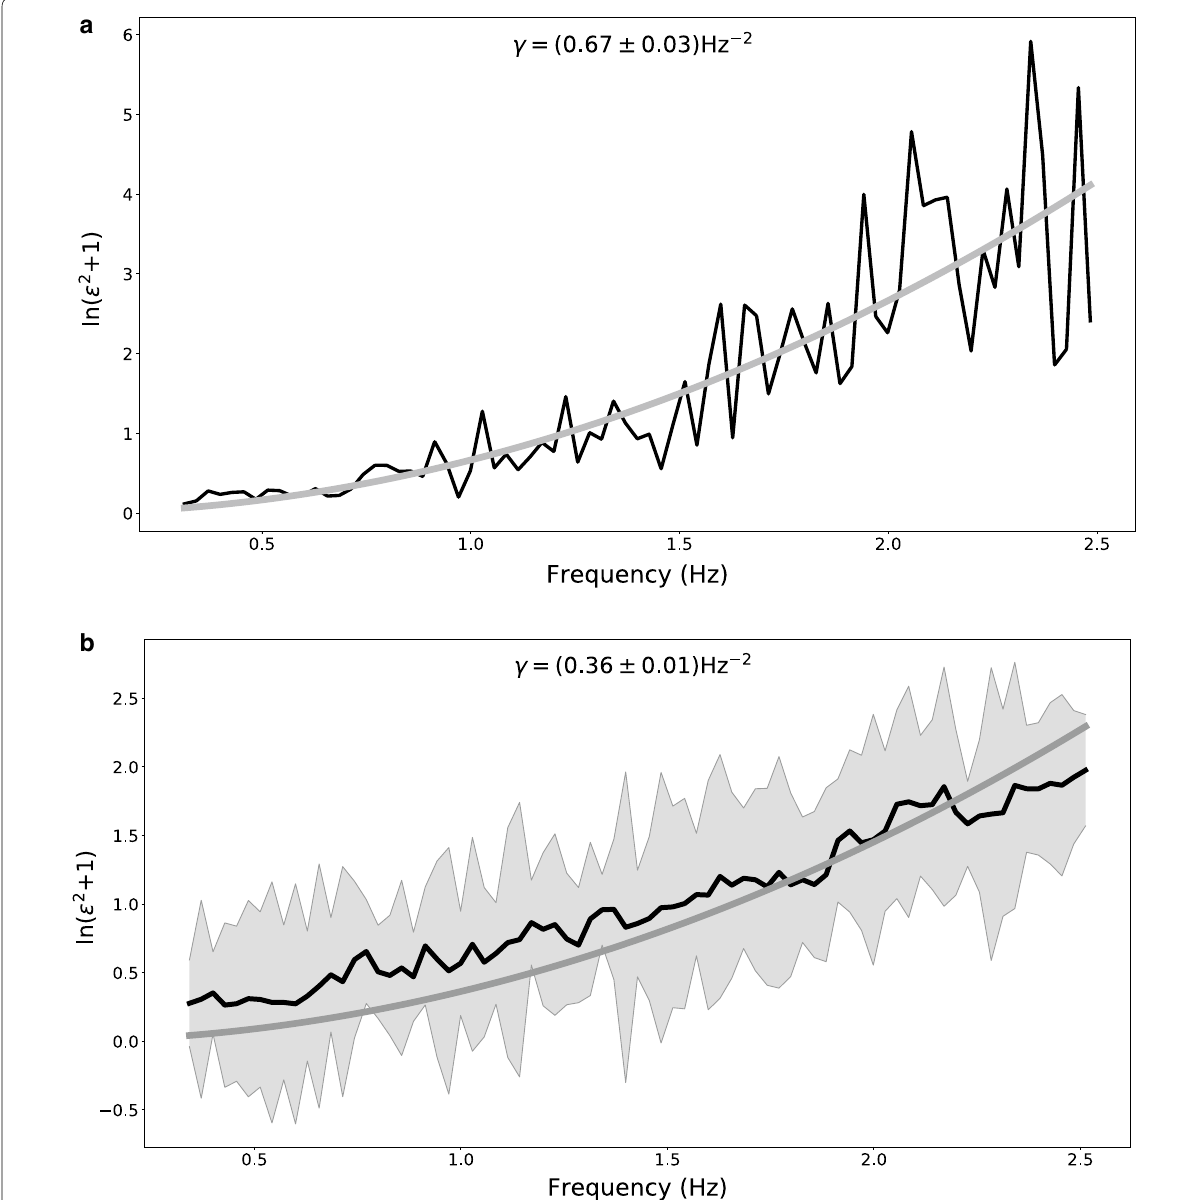
Fig. 7 Plot of ln( ε 2 1) against frequency for the determination of the parameter γ. The regression line (grey line) is derived from a quadratic + least-squares fit of Eq. (3) in “Teleseismic fluctuation wavefield method” section. a Fit of ln( ε 2 γ 0.67 Hz − 2 . b Fit of stacked ln( ε 2 1) for all the events with ⟨ γ ⟩ = + ( σ denotes the standard